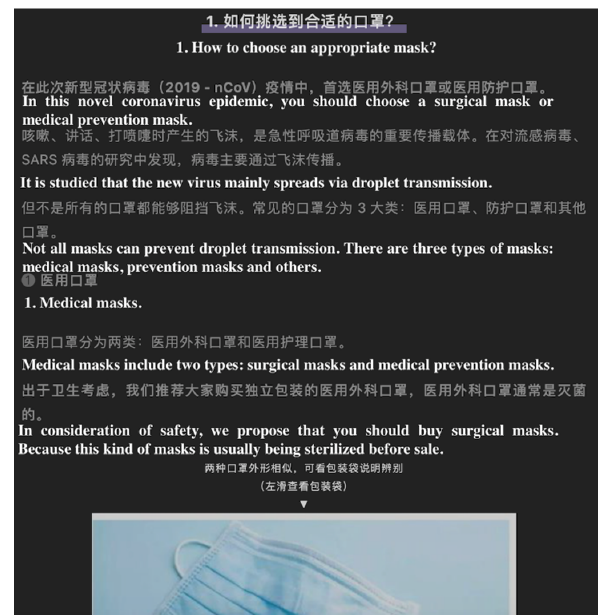
Figure 8. Screenshot of an instruction-type article. From: DingXiangYiSheng. Don’t put your mask